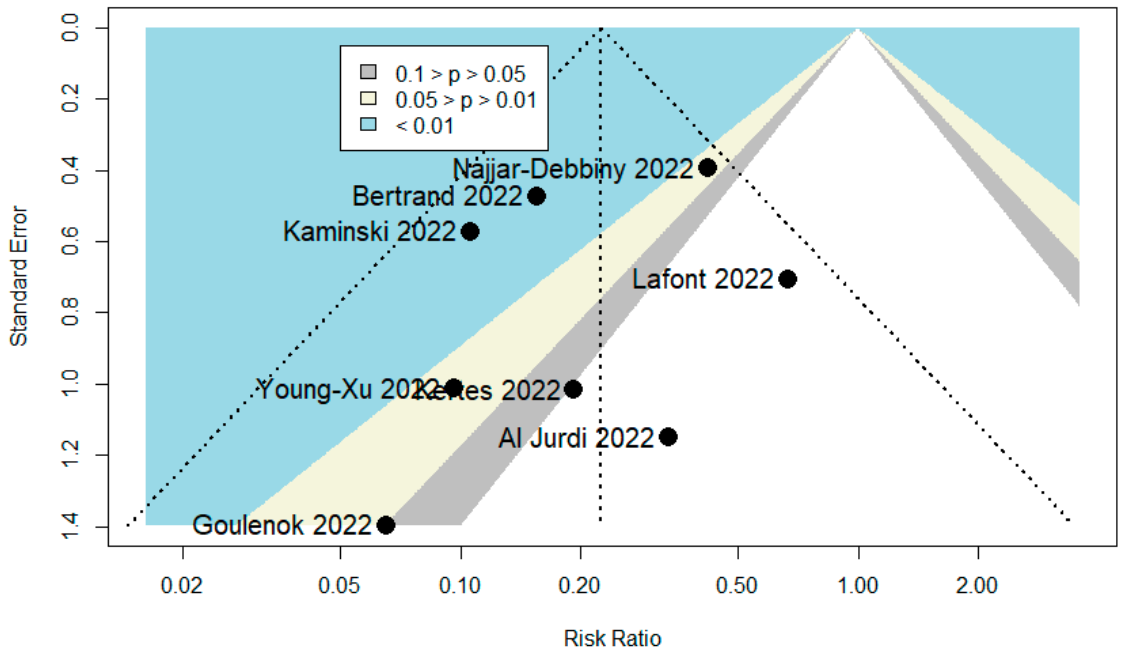
Figure 3. Funnel plot to evaluate publication bias for the pooled effect size to determine the rate of COVID-19-related hospitalization associated with TGM/CGM-based treatment in patients at high risk for breakthrough and severe SARS-CoV-2 infection.